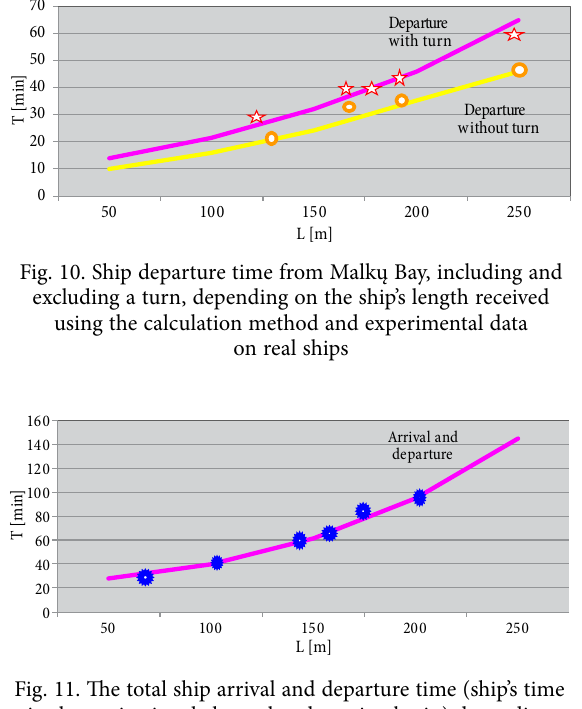
Fig. 11. The total ship arrival and departure time (ship’s time in the navigational channel and turning basin) depending on the ship’s length received using the calculation method and experimental data on real